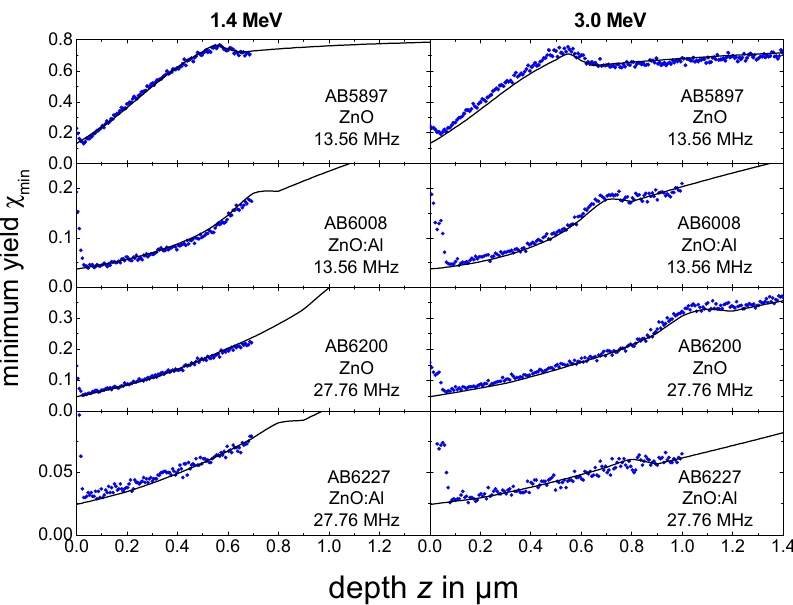
Figure 6. Measured (symbols) and calculated (solid lines) minimum yield χ min versus depth z for He ion energies of 1.4 MeV (left column) and 3.0 MeV (right column). The names of the samples are given in the figure.